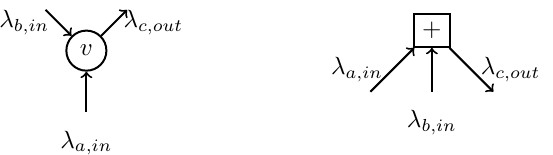
Figure 3: Illustration of the local rules for estimating the normalized MI